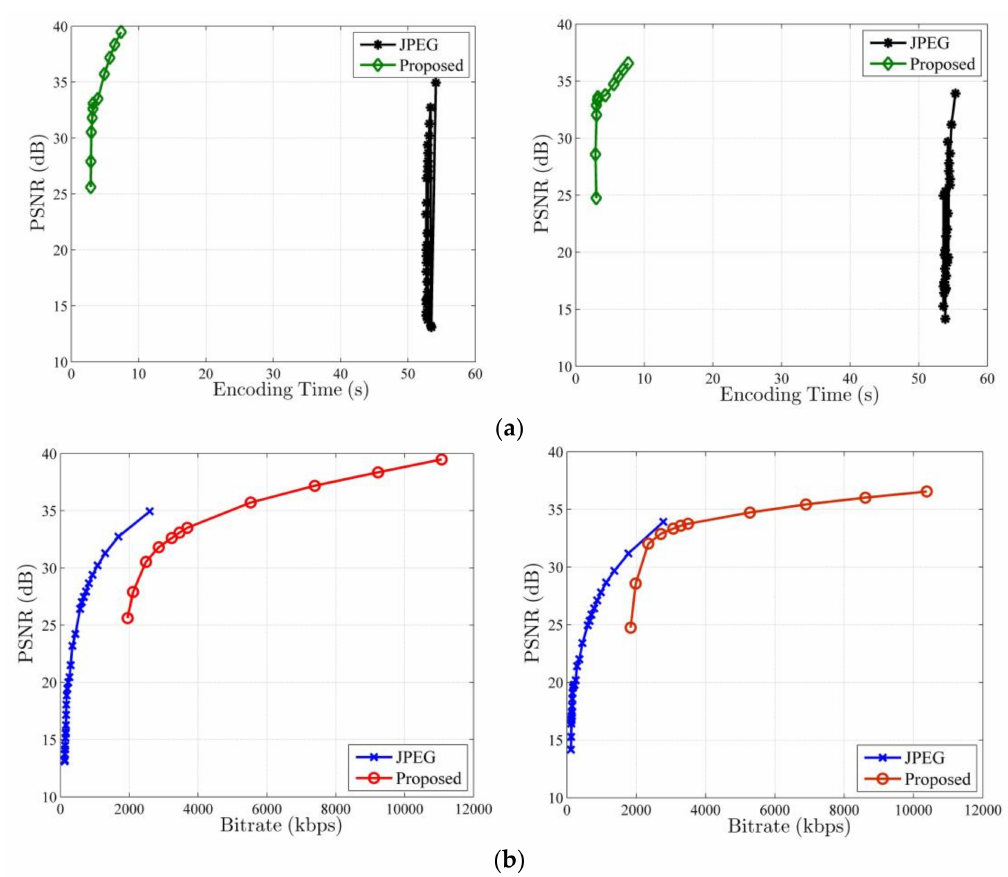
Figure 6. Time-distortion and rate-distortion curves of the proposed system and JEPG for Foreman and Container sequences. ( a ) Time-distortion curve and ( b ) Rate-distortion curve. Left is Foreman , and Right is Container